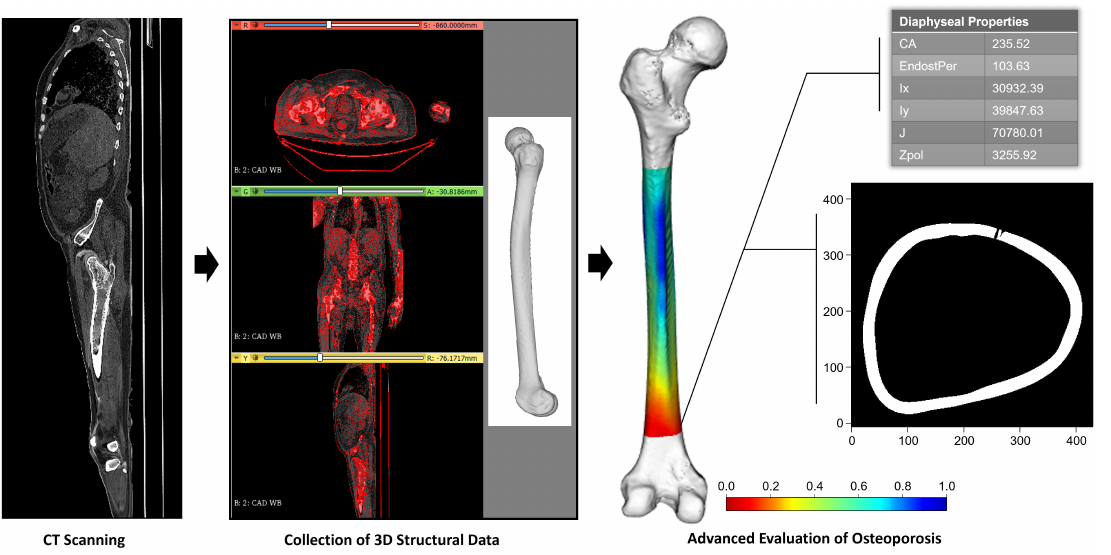
Figure 7. Conceptualization of how CT scans could be used to obtain comprehensive, patient- specific information about osteoporosis risk. Left femur with heat map showing regional bone thickness, a sampling location showing a cross-section of osteoporotic bone, and an example of regional quantitative data that can be calculated at a given sampling location. Cortical area (CA), endosteal perimeter (EndostPer), area moment of inertia around the x axis ( I x ) , area moment of inertia around the y axis ( I y ) , polar moment of inertia ( J ), and polar section modulus ( Z pol )